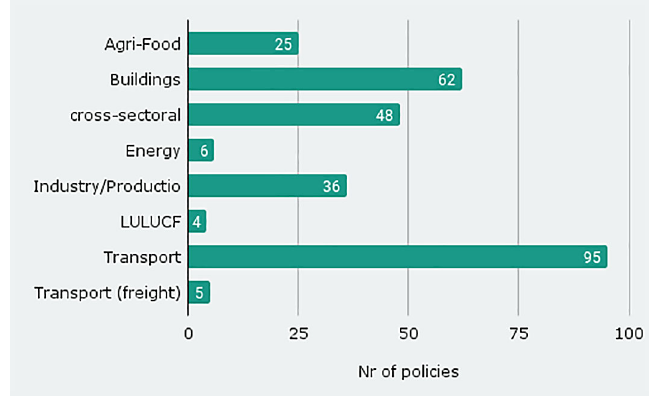
Figure 1. Number of policy instruments by